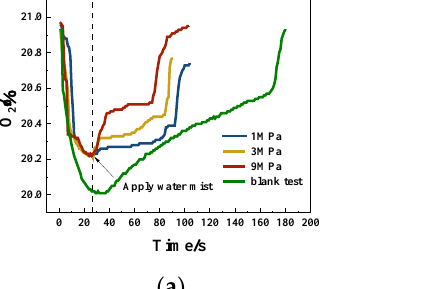
( b ) Figure 8. Change curve of CO concentration under different pressures: ( a ) materials are placed hor- izontally, ( b ) materials are placed vertically. From the change curve of O 2 concentration in Figure 9, we can see that the oxygen concentration after the application of water mist decreases faster than that without water mist. The oxygen concentration after the water mist was applied was always lower than the oxygen concentration without the water mist, which indicated that the water mist